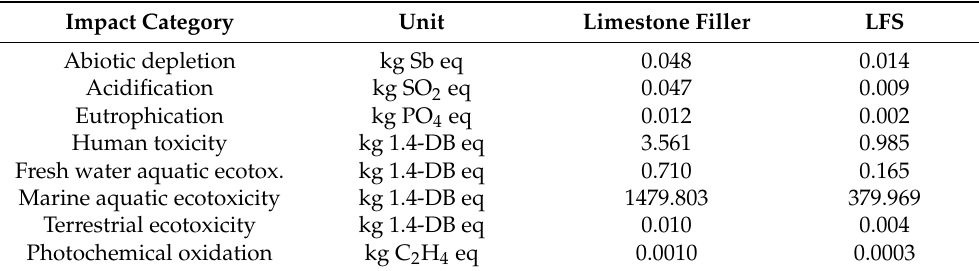
Table 5. Impacts associated with the processing of natural siliceous aggregates and electric arc furnace slags for use in bituminous mixtures. Impact